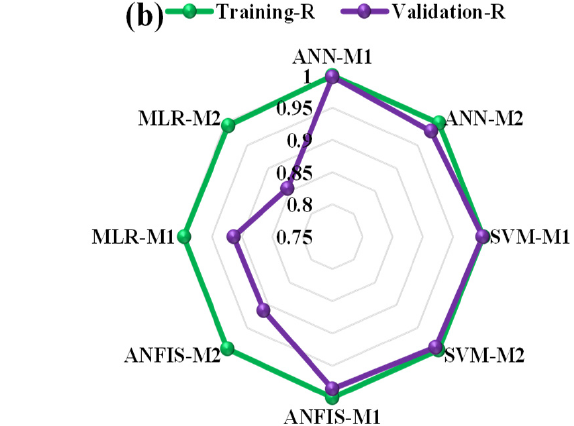
Figure 7. Radar chart for ( a ) goodness-of-fit and ( b ) correlation coefficient for TDS. Furthermore, a radar plot was used to compare the predictive accuracy of the